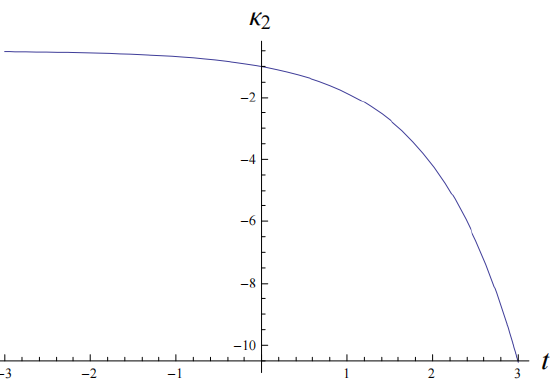
κ in Equation (122). 1